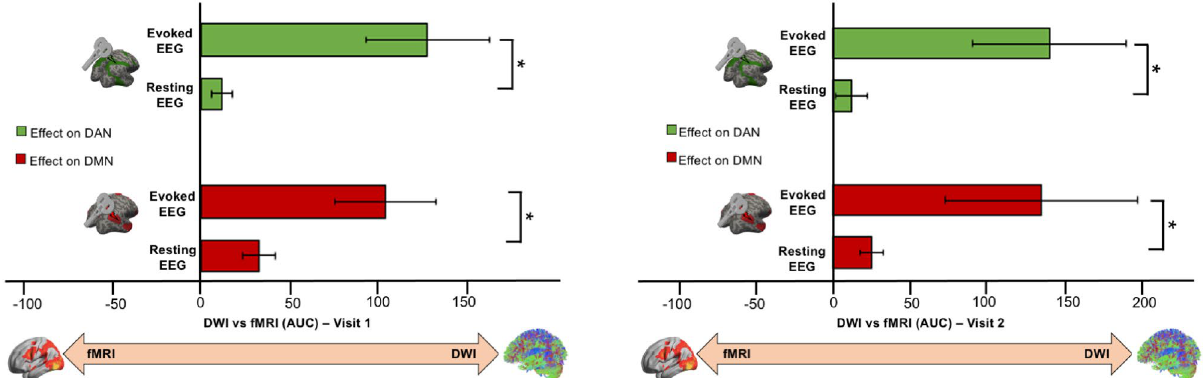
Figure 3. Spontaneous vs Evoked EEG activity. TMS-evoked signal propagation was significatively higher compare to resting-state EEG activity in structurally connected regions for both DMN (red bar) and DAN (green